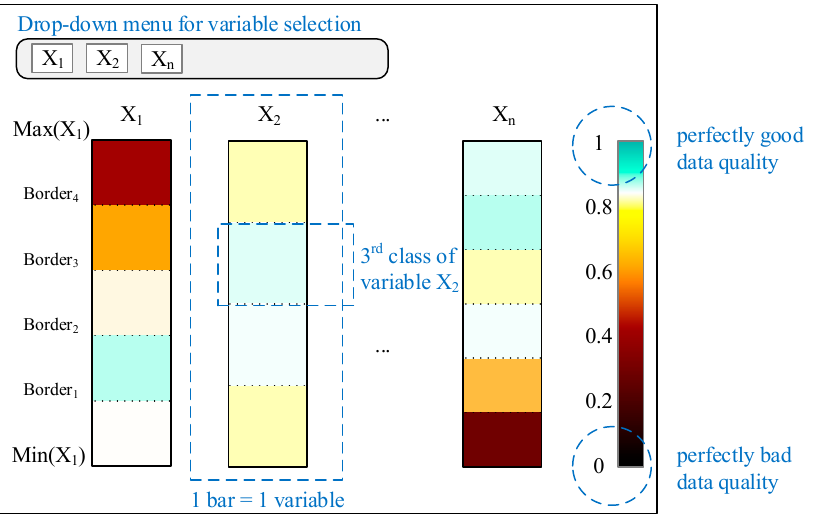
Figure 7. Schematic concept of the heat map for visualizing data set completeness in multi ‐ dimensional data sets.